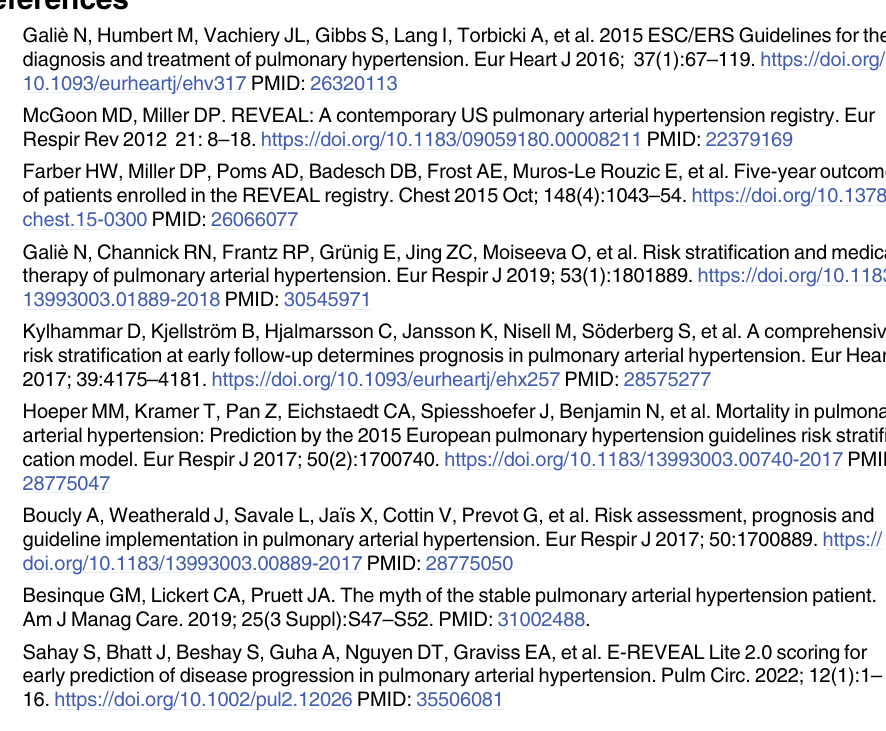
S2 Table. Characteristics of the population according to TAPSE/sPAP ratio values. S3 Table. Univariate regression analysis of hemodynamic